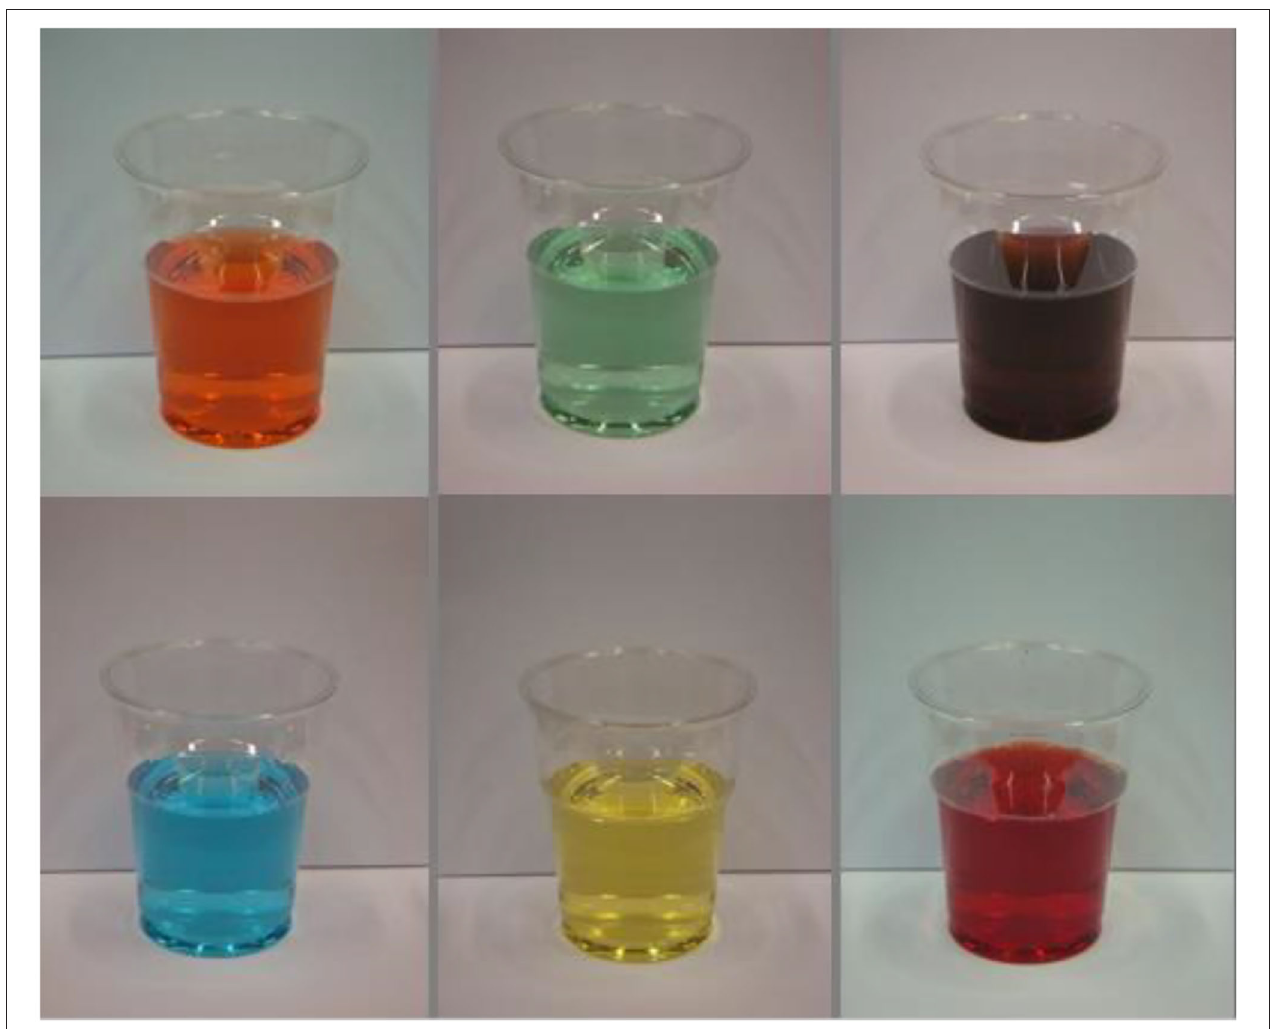
FIGURE 2 | The six drinks shown to participants in the UK and Taiwan in a cross-cultural study of the flavor expectations elicited by color reported by Shankar M. U. et al. (2010)